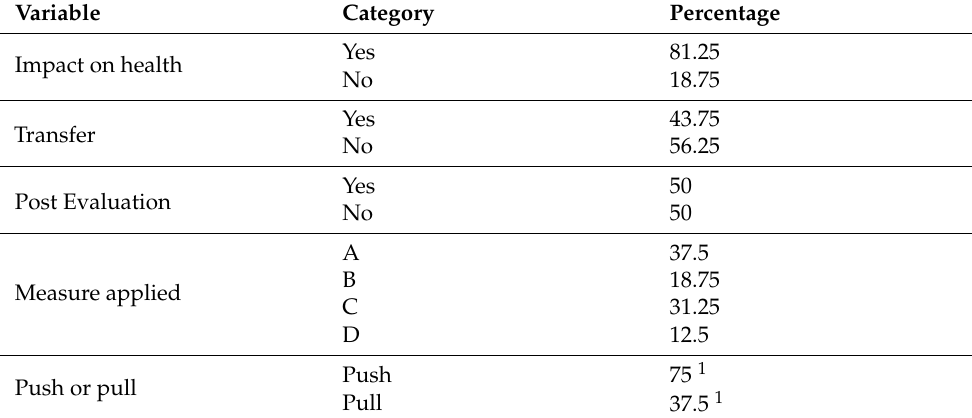
Table 1. Descriptive data of the study variables in the